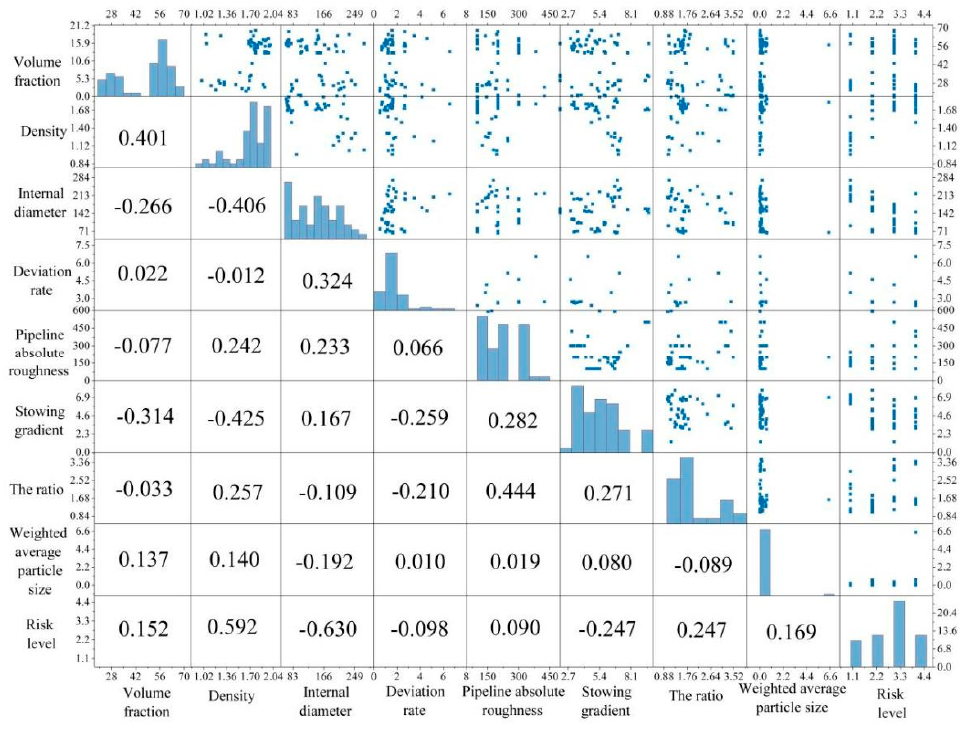
Figure 3. The correlation coefficient matrix of backfilling pipeline failure risk database.